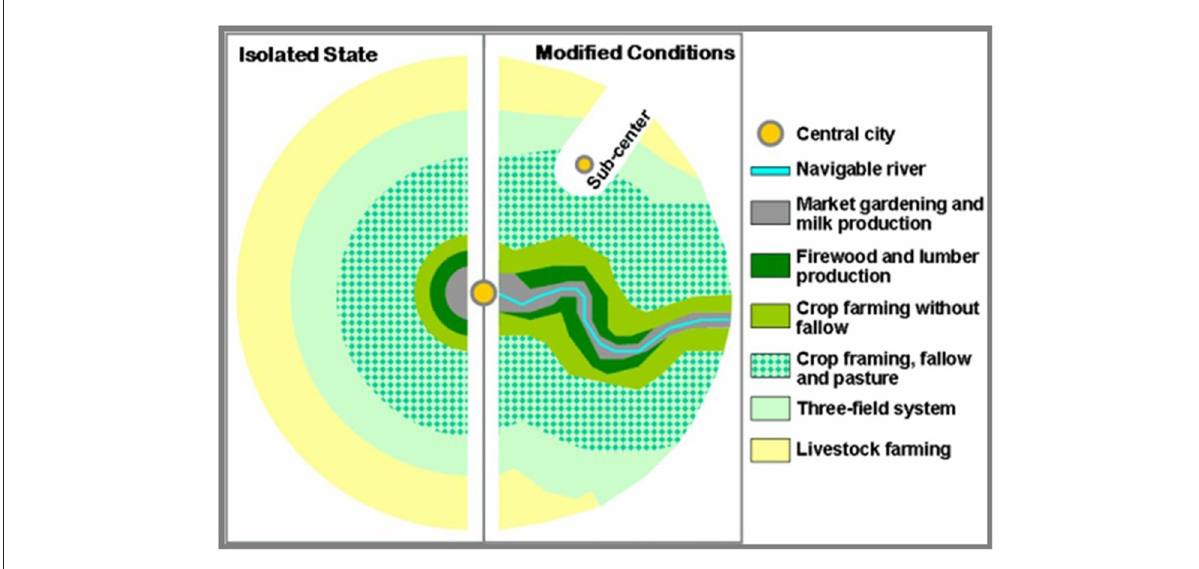
FIGURE1 Concentric rings model for locational theory of Von Thünen (1826).